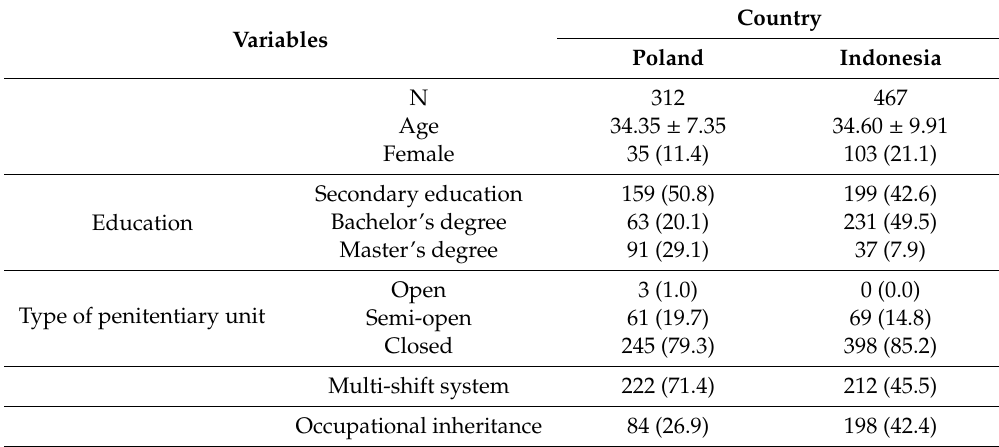
Table 1. Descriptive statistics of the surveyed respondents from Poland and